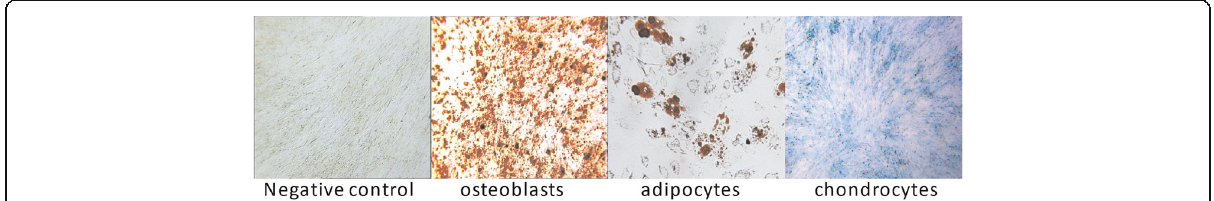
Fig. 2 Representative images illustrating the MSC multilineage potential. Each lineage differentiation was assessed by using both specific induction medium and staining techniques